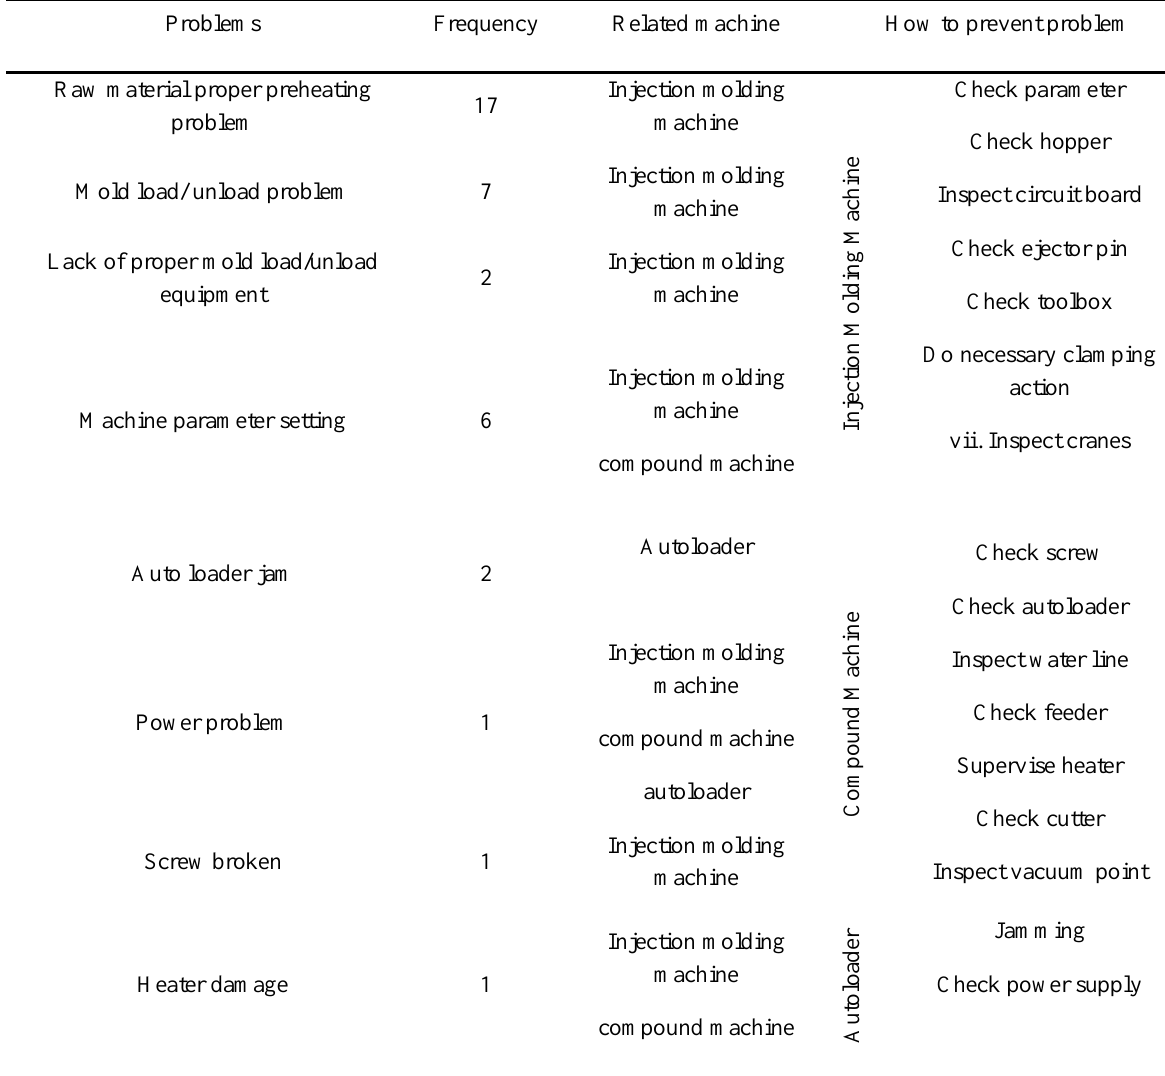
Table 8. Problems related to each